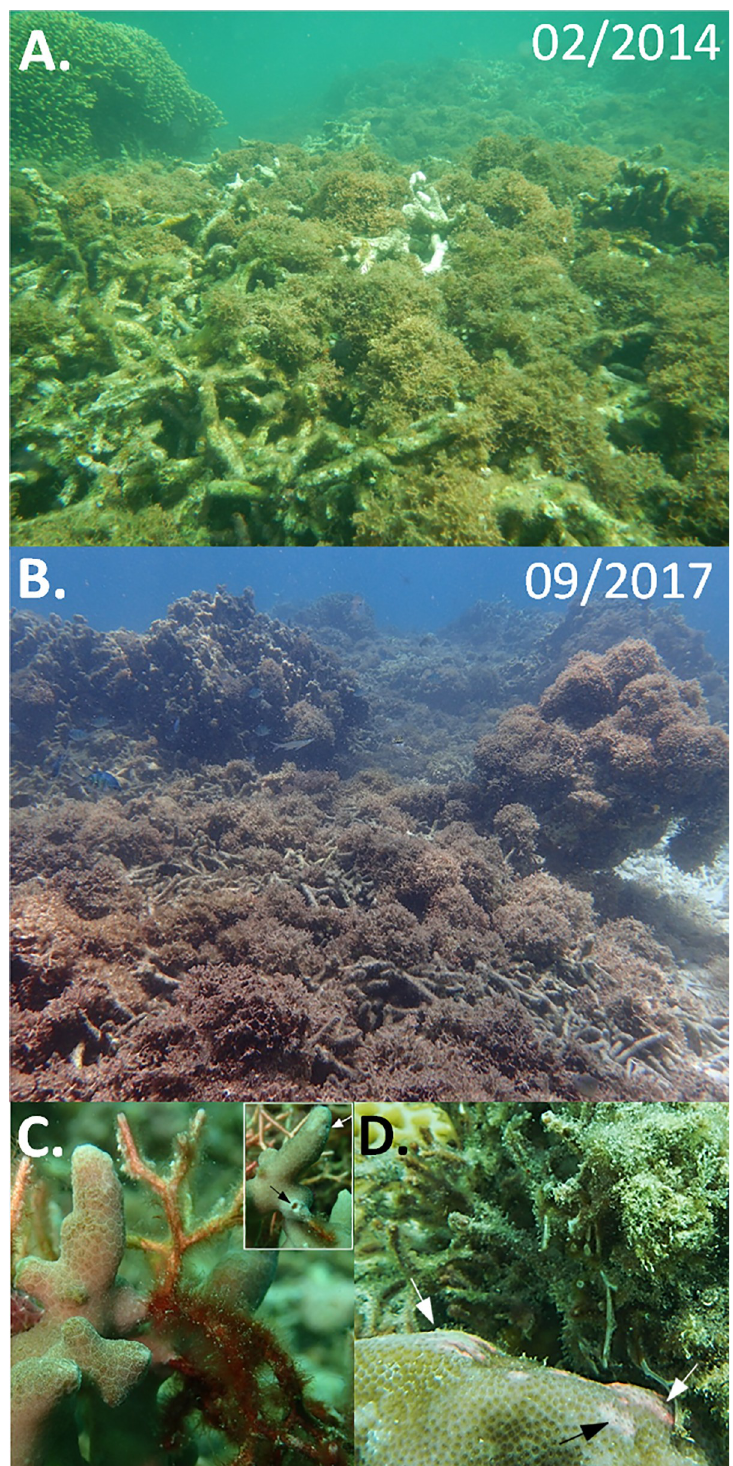
Fig 5. Observational photo-evidence of a prolonged Galaxaura overgrowth. A-B) A degraded patch reef in the southeast lagoon of Dongsha Atoll has been overgrown by G . divaricata for at last 3.5 years (3–5 m depth at site 9). Photos were taken in A) February 2014, with water temperature = 22.5˚C; and B) in September 2017 with water temperature = 29˚C. The holdfast of G . divaricata penetrates a branching Porites coral ( P . cylindrica ), creating small